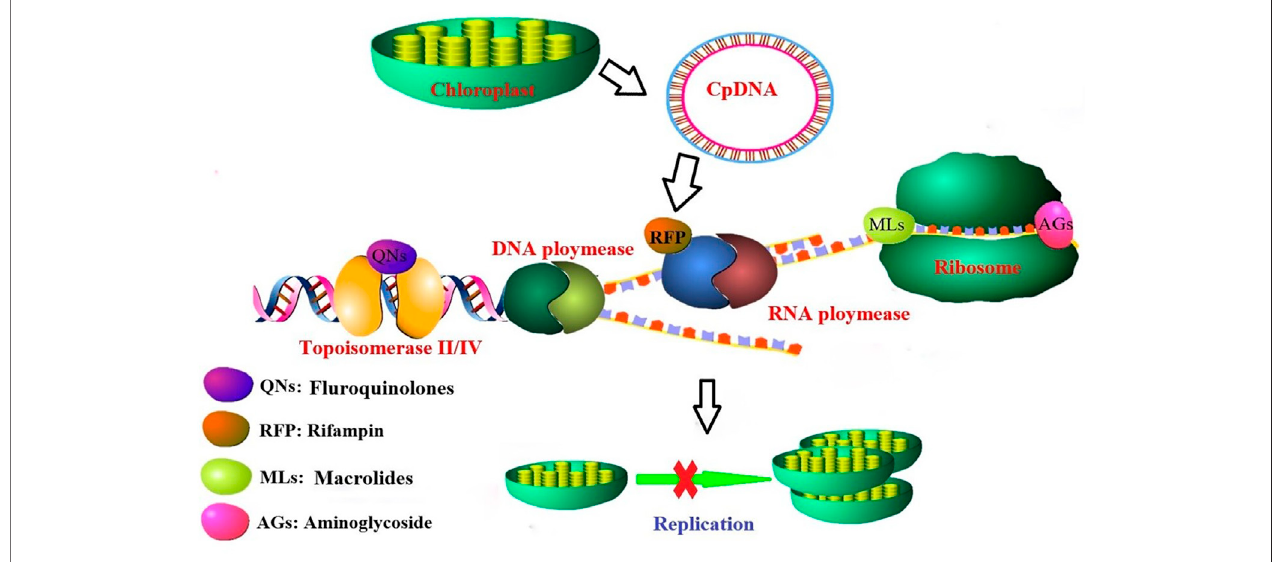
FIGURE3 | Tetracycline and sulfonamide inhibit algal growth by affecting their chloroplast replication and transcription/translation.